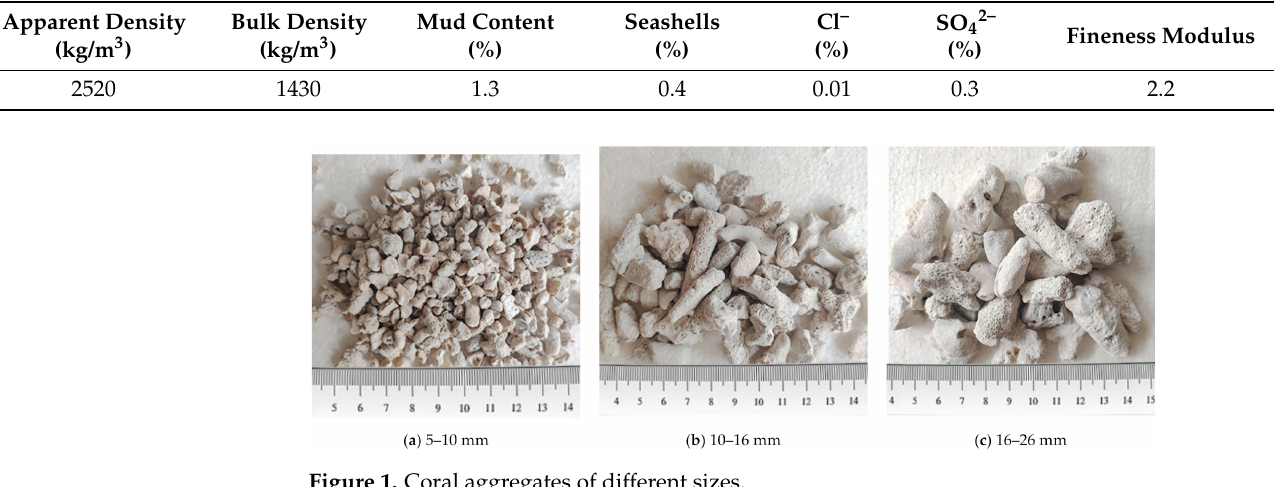
Table 3. Physical properties and chemical composition of sea sand.